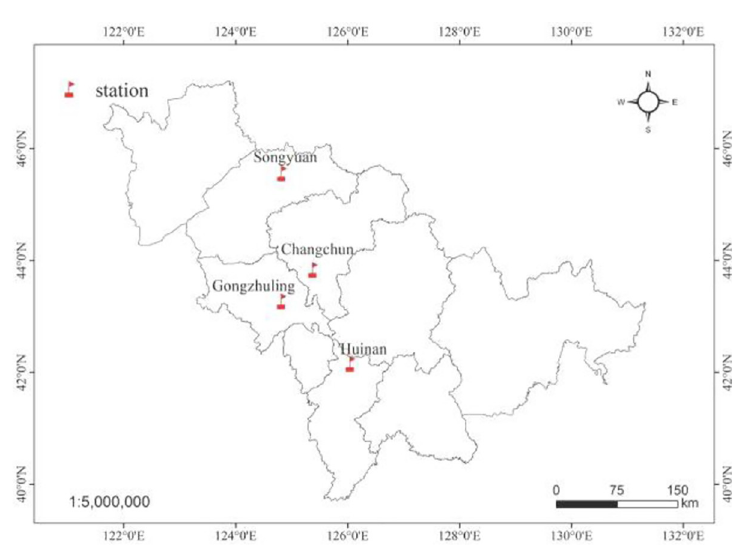
Fig 1. The map of experimental fields in four maize fields of Jilin province, northeastern